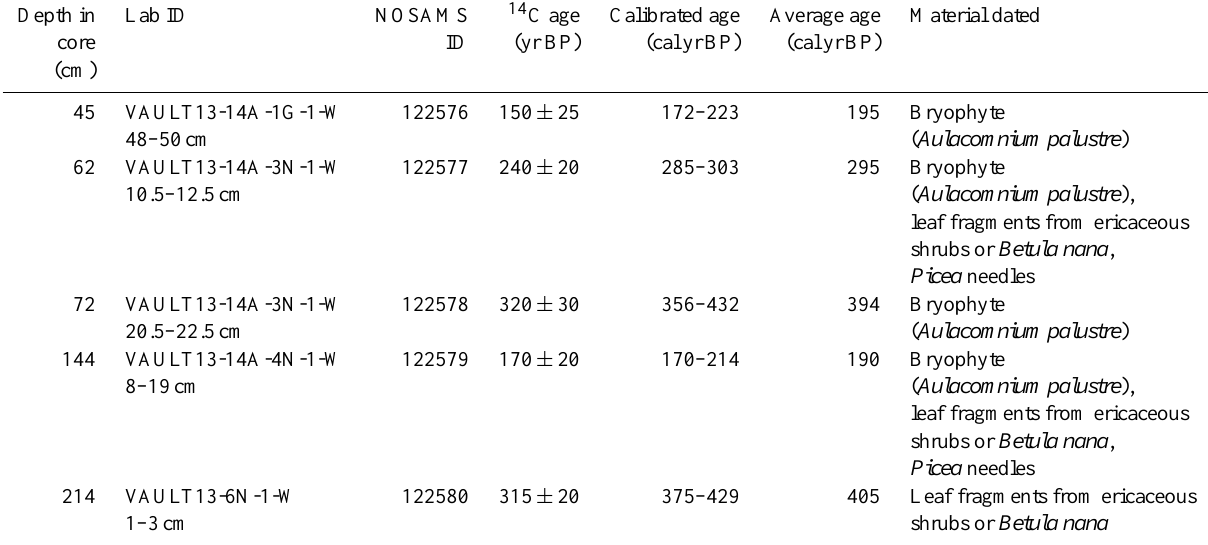
Table 1. Radiocarbon ages of macrofossils picked from the Vault Lake sediment core, calibrated to calendar 2 σ years before present (BP) using Calib 7.0 (Reimer et al.,